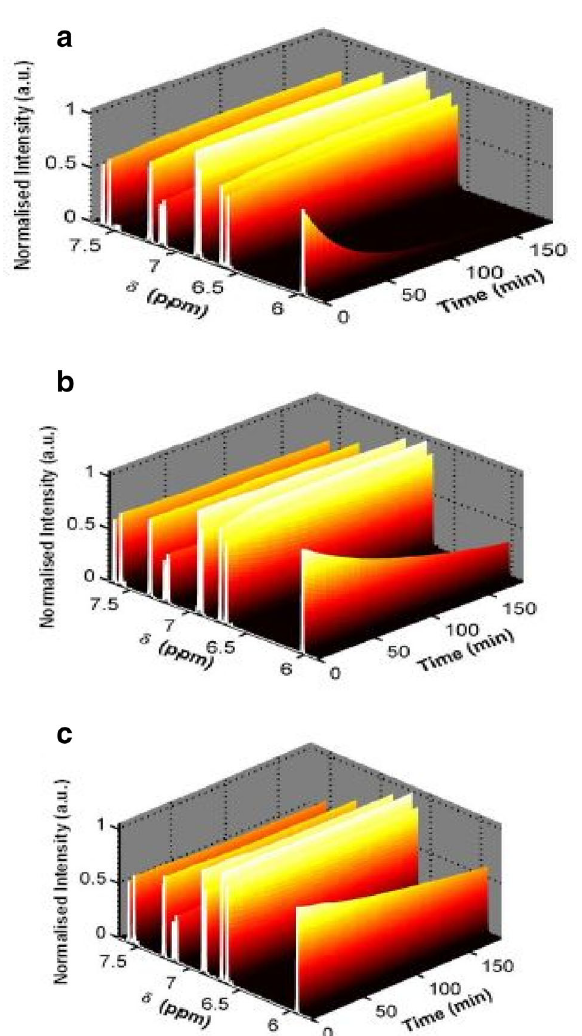
Fig. 8 NMR spectra for curcumin at 45 (cid:3) C a methanol, b acetone, and c